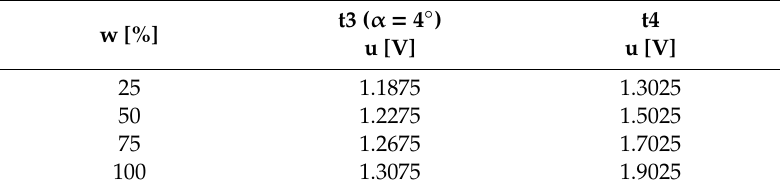
Table 2. Motor controlling voltage for the amplification coe ffi cient values